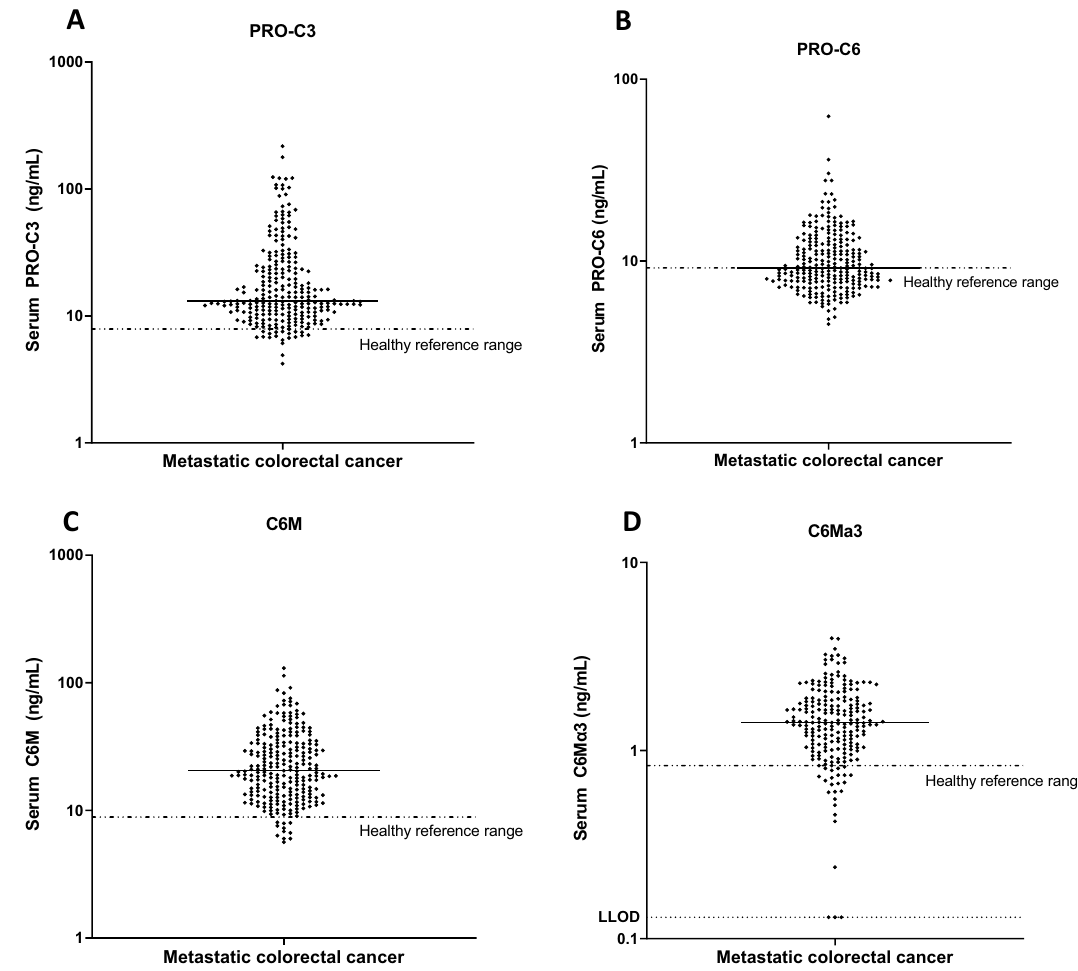
Figure 2. Serum levels of four different biomarkers reflecting ( A ) formation of collagen type III (PRO-C3), ( B ) formation of collagen type VI (PRO-C6), ( C ) degradation of collagen type VIα1 (C6M) and ( D ) degradation of collagen type VIα3 (C6Mα3) in patients with metastatic colorectal cancer with their respective reference range from healthy controls (dotted line). Black line, median. LLOD; lower limit of